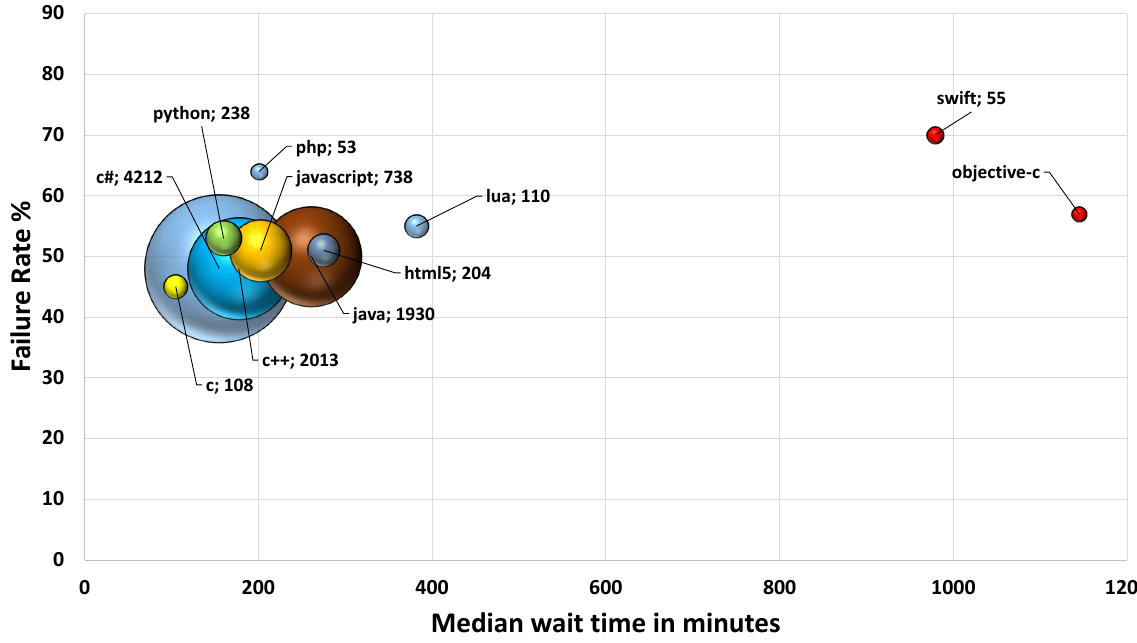
Figure 4. Failure Rate and Median Wait Time for Programming